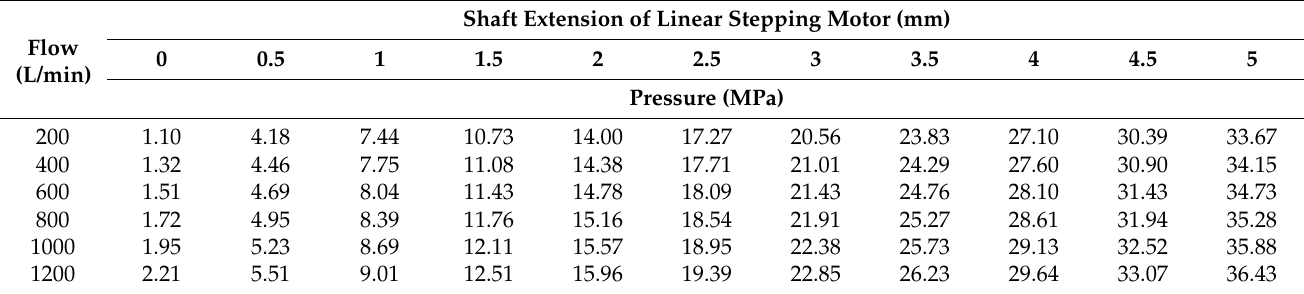
Table 2. Pressure values for various pump flows and stepper motor shaft